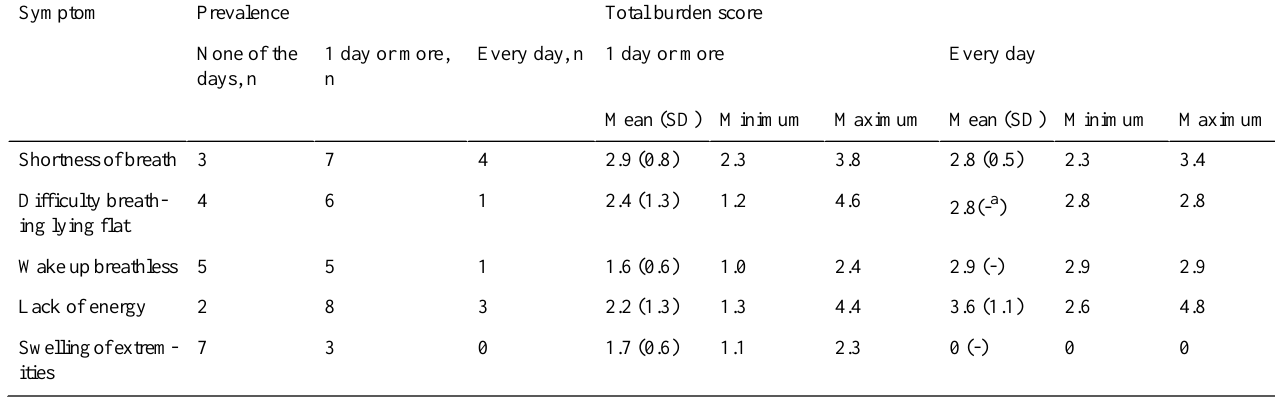
Table 3. The number of participants experiencing (prevalence) and total burden score (mean of the frequency, severity, and distress scores) of the 5 heart failure symptoms and signs during the 30-day postdischarge assessment period